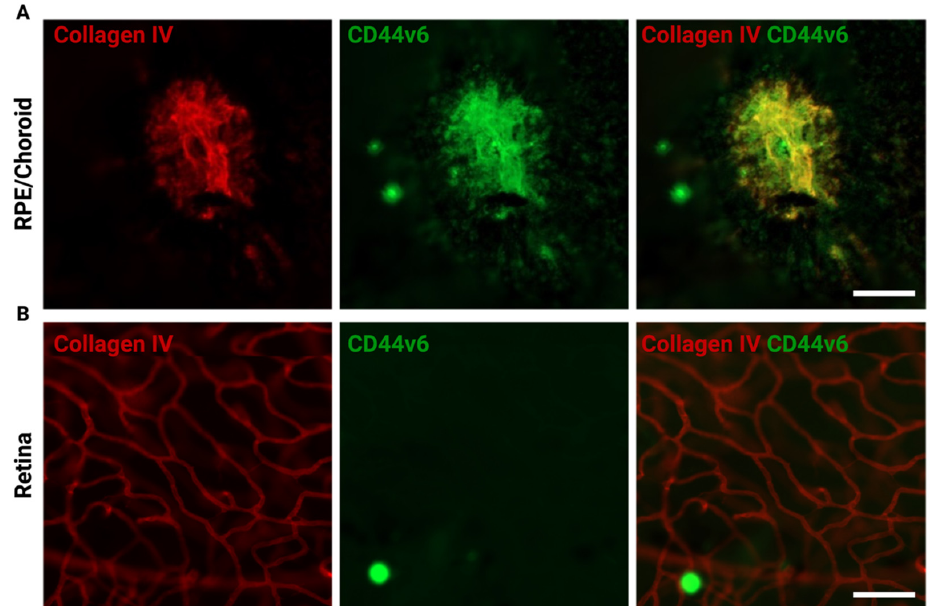
Figure 4. Expression Pattern of CD44v6 in Laser-induced Choroidal Neovascularization (CNV). ( A ) CD44v6-expression in proliferating endothelial cells in a mouse model of laser-induced CNV. ( B ) Absence of CD44v6 in quiescent retinal blood vessels. Scale bar represents 100 µm. Primary antibodies were monoclonal rat anti-CD44v6 (clone 94A) and polyclonal rabbit anti-Collagen IV, visualized by secondary antibodies chicken anti-rabbit Alexa Fluor TM 647 and donkey anti-rabbit Alexa Fluor TM 488. Whole-mount staining was performed as described previously [8].